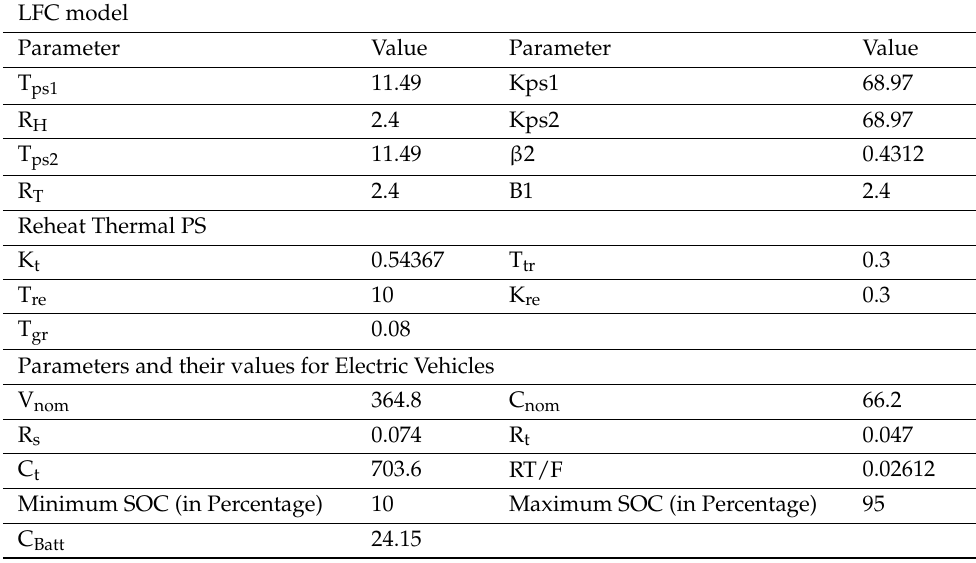
Table A1. Hybrid PS and Their Parametric Values